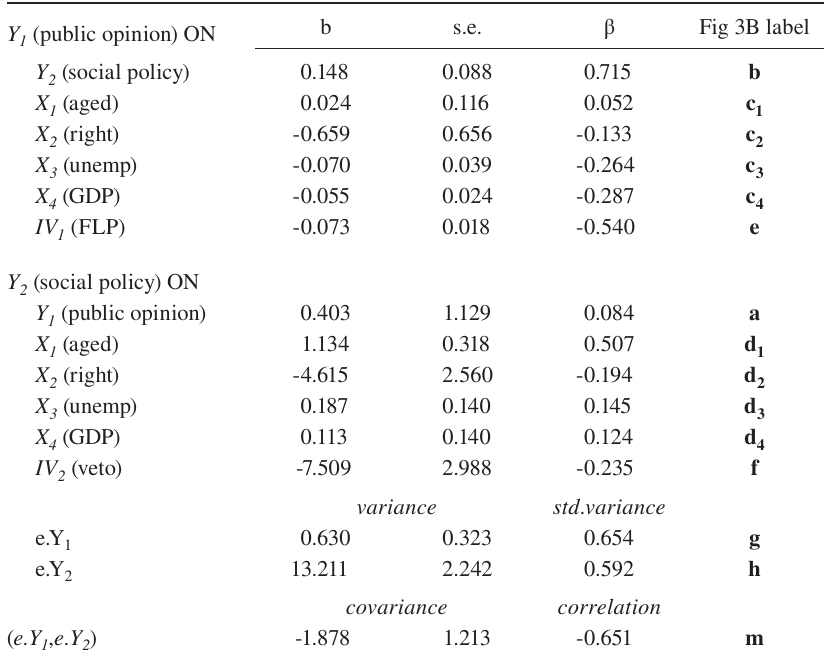
Results from M1. Freely Estimated Simultaneous Feedback